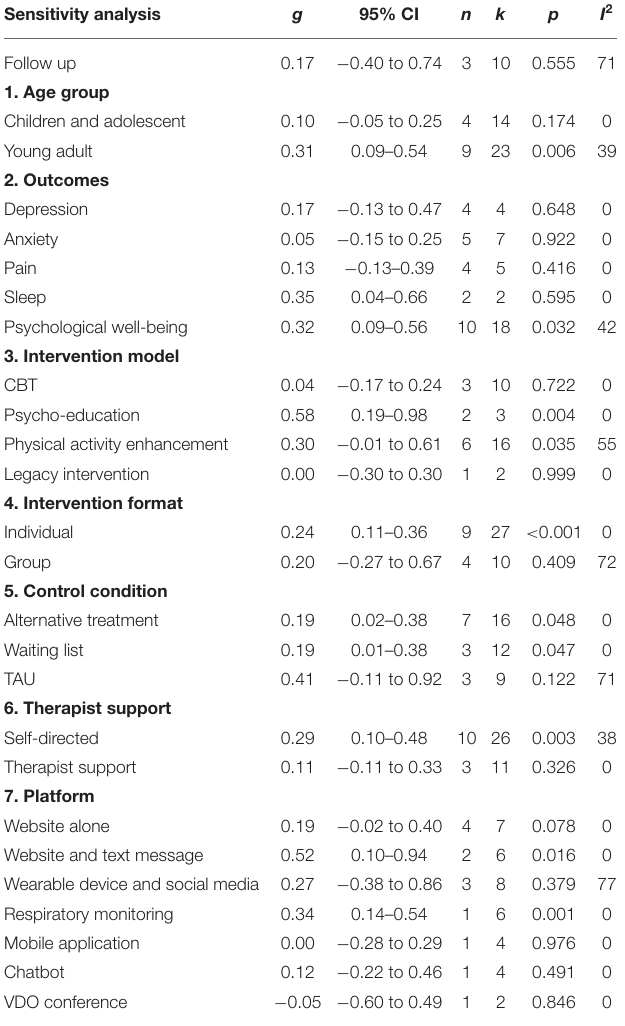
TABLE 3 | Sensitivity analysis at